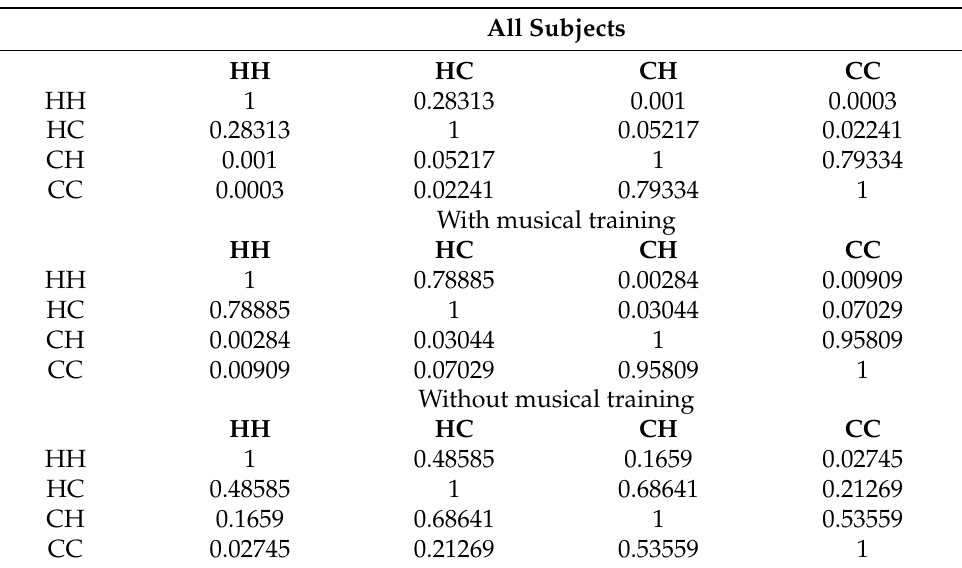
Table 2. Chi-squared test (with α = 0.05) assessing whether the perception of the music (music or non-music) was different for all the possible combinations of human/computer performer/composer. HH = music composed and performed by a human; HC = music composed by a human and per- formed by a machine; CH = music composed by a machine and performed by a human; CC = music composed and performed by a